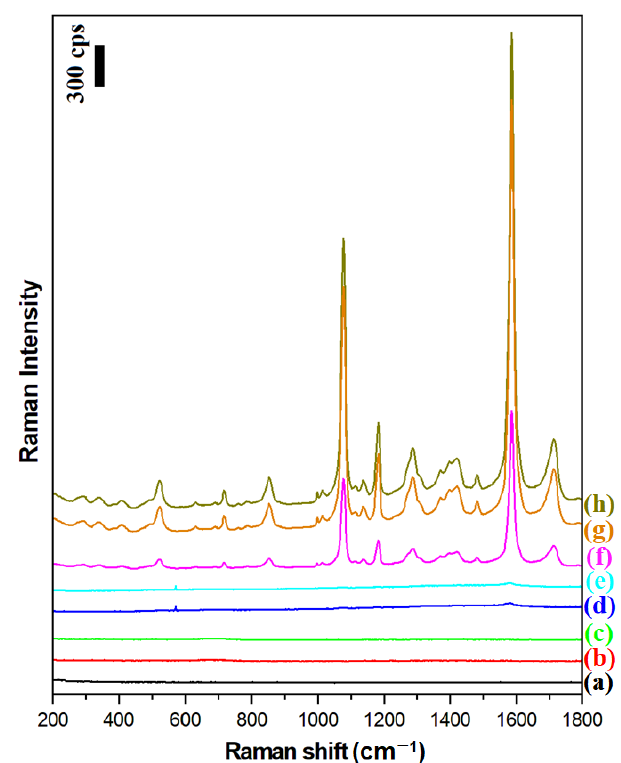
Figure 5. Raman spectra of: ( a ) the Pt/p-MBA monolayer before the deposition of the magnetic – plasmonic nanoresonators, ( b ) the Fe 3 O 4 @Ag nanoparticles deposited on the flame-annealed platinum plate, ( c ) the (Fe 3 O 4 @Ag)@SiO 2 nanoparticles deposited on the flame-annealed platinum plate, ( d ) the Pt/p-MBA monolayer covered with Fe 3 O 4 @Au nanoparticles, ( e ) the Pt/p-MBA monolayer covered with (Fe 3 O 4 @Au)@SiO 2 nanoparticles, ( f ) the Pt/p-MBA monolayer covered with Ag nanoparticles, ( g ) the Pt/p-MBA monolayer covered with (Fe 3 O 4 @Ag)@SiO 2 nanoparticles, and ( h ) the Pt/p-MBA monolayer covered with Fe 3 O 4 @Ag nanoparticles. The wavelength of the excitation radiation: 532 nm. The power of the laser beam on the laser head: 70 mW. The accumulation time for a single Raman spectrum: 10 s.